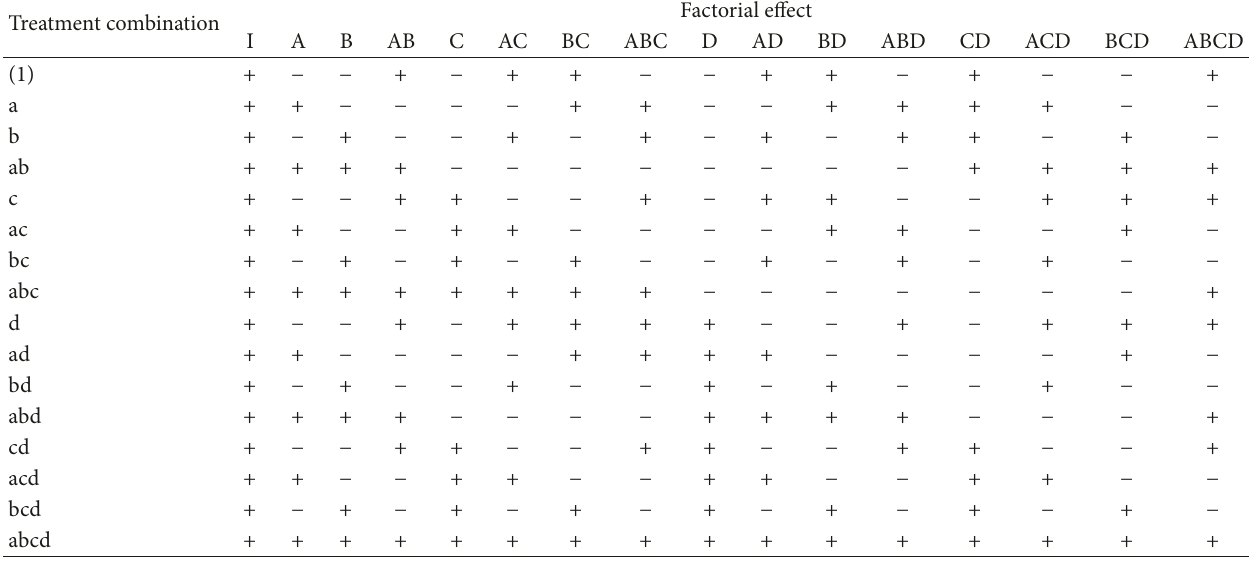
Table 2: Algebraic signs representing the contrast constants for the 2 4 factorial design.